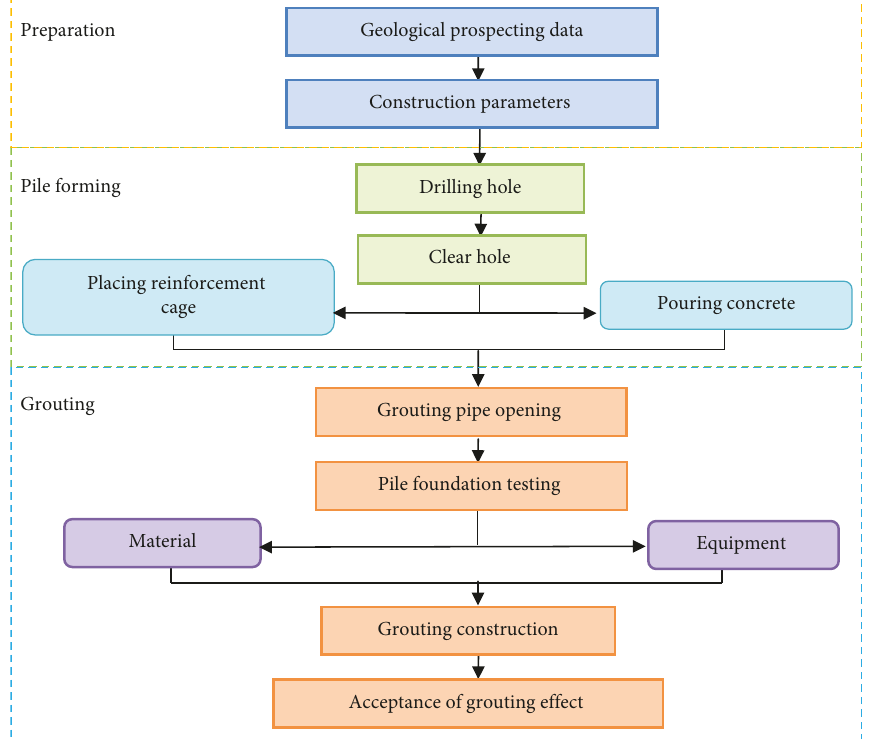
Figure 3: Grouting